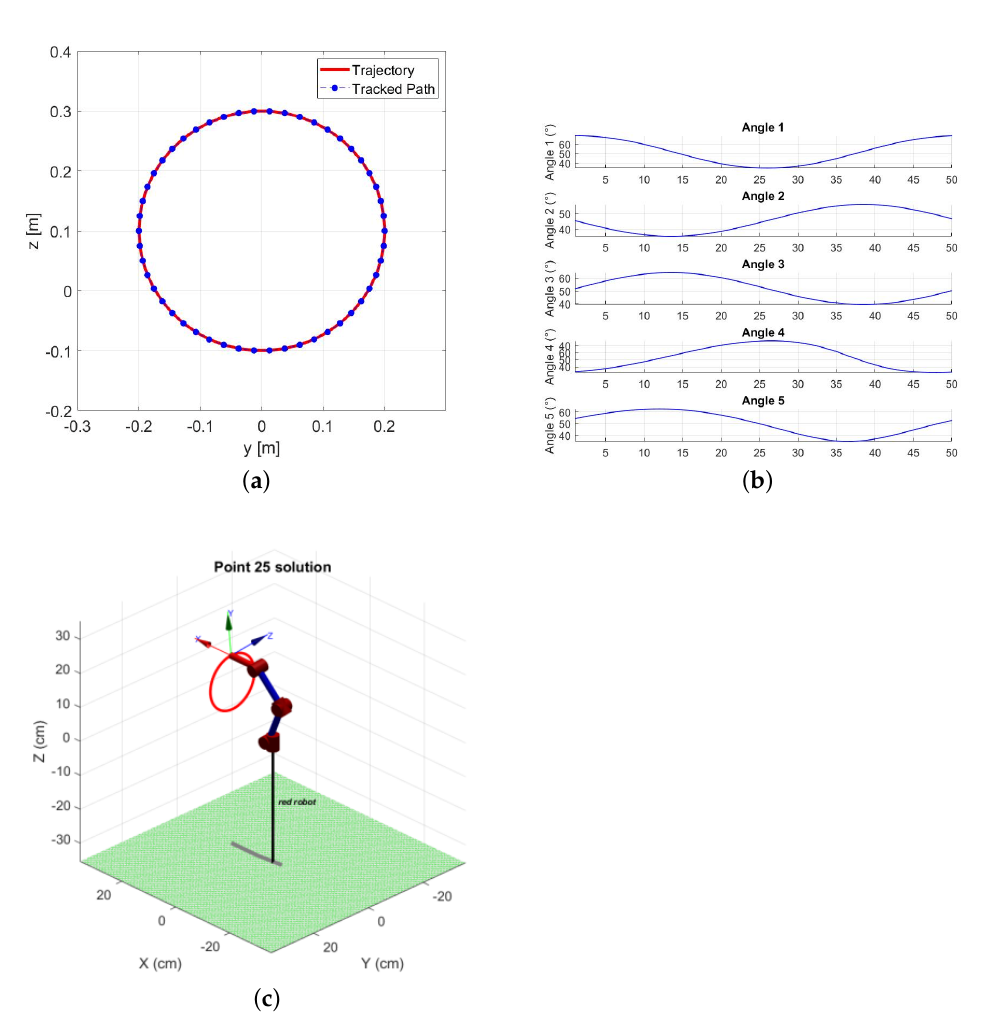
Figure 7. Circular path tracking of 50 points: ( a ) The input trajectory and the tracked trajectory by robotic arm, ( b ) Angle values resulted by MO-m-PSO for each point of the trajectory, ( c ) 3D representation of the robotic arm and the circular